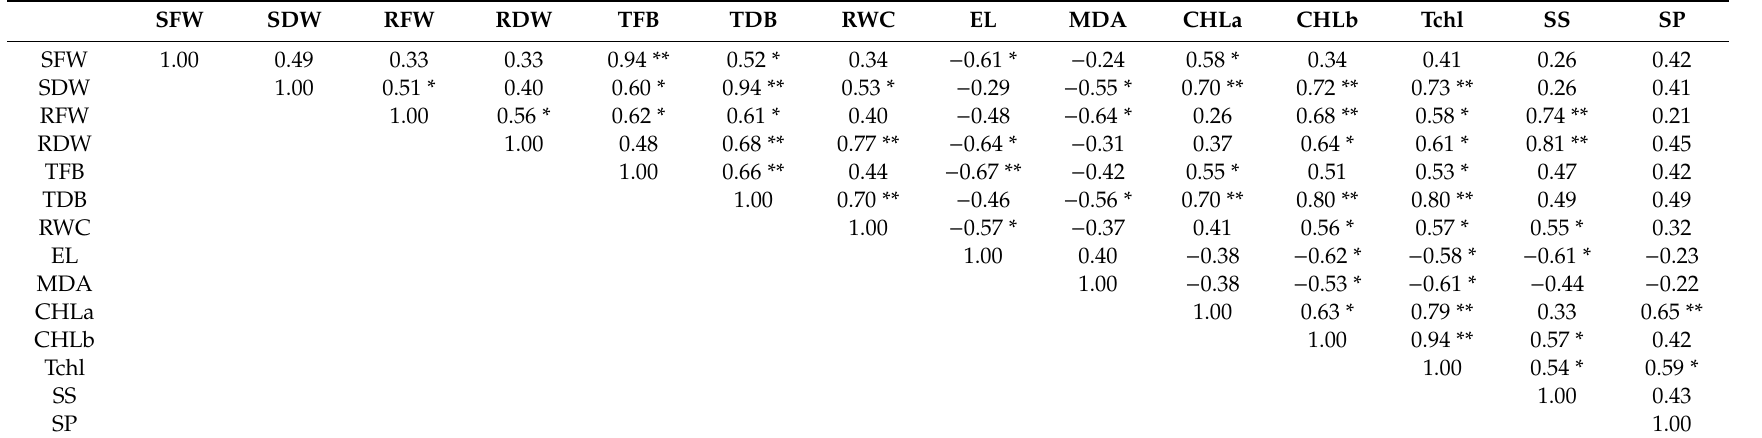
Table 4. Correlation analysis of biomass and physiological